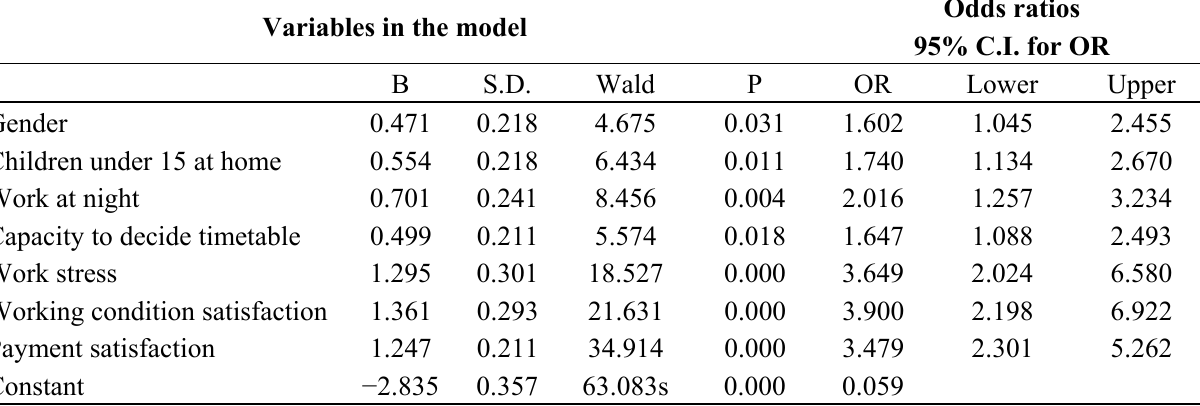
Table 4. Logistic regression: factors that determine workplace bullying (Confidence intervals for the odds ratio of Model